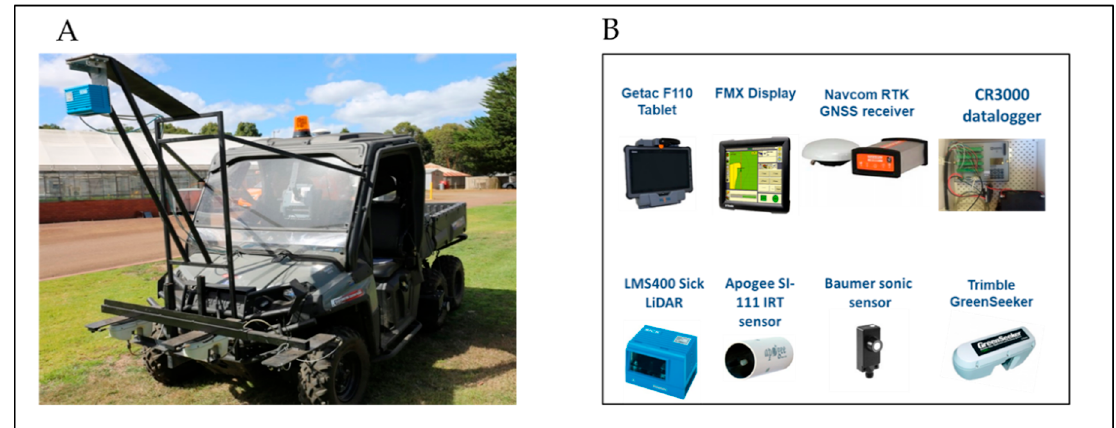
Figure 2. The ground-based phenotyping platform named as “Phenorover” assembled in Hamilton Centre, AVR for field phenotyping of perennial ryegrass. ( A ) Semiautomated ground vehicle named Phenorover; ( B ) list of deployed sensors on Phenorover.